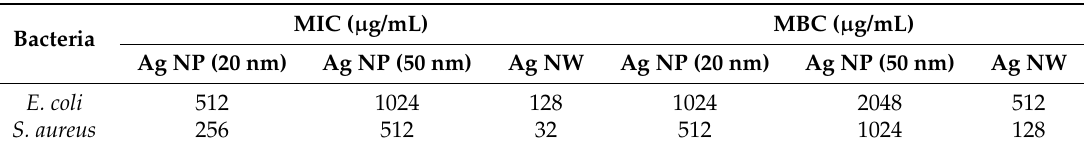
Table 1. The minimum inhibitory concentration (MIC) and minimum bactericidal concentration (MBC) values of the as-prepared nanocrystal products.